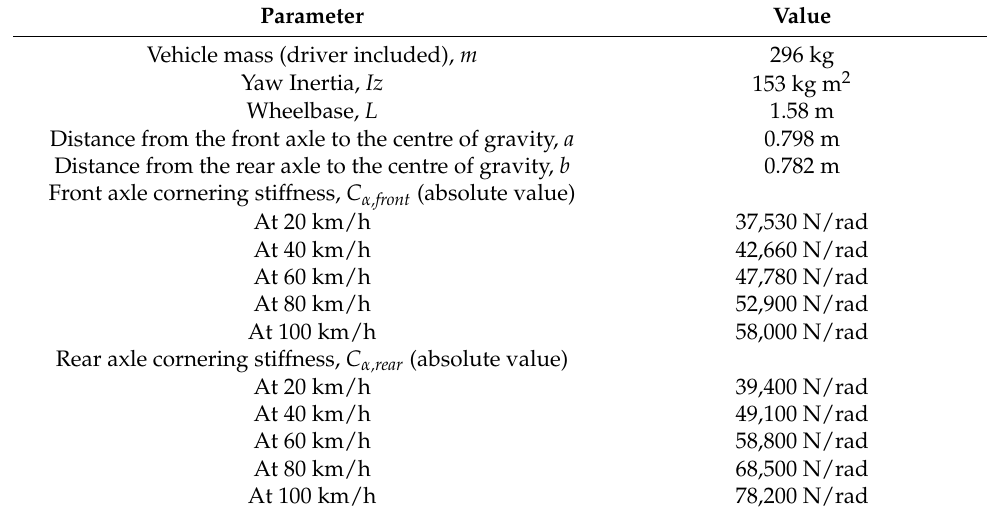
Table 6. Linearized bicycle model properties. Parameter Value Vehicle mass (driver included), m 296